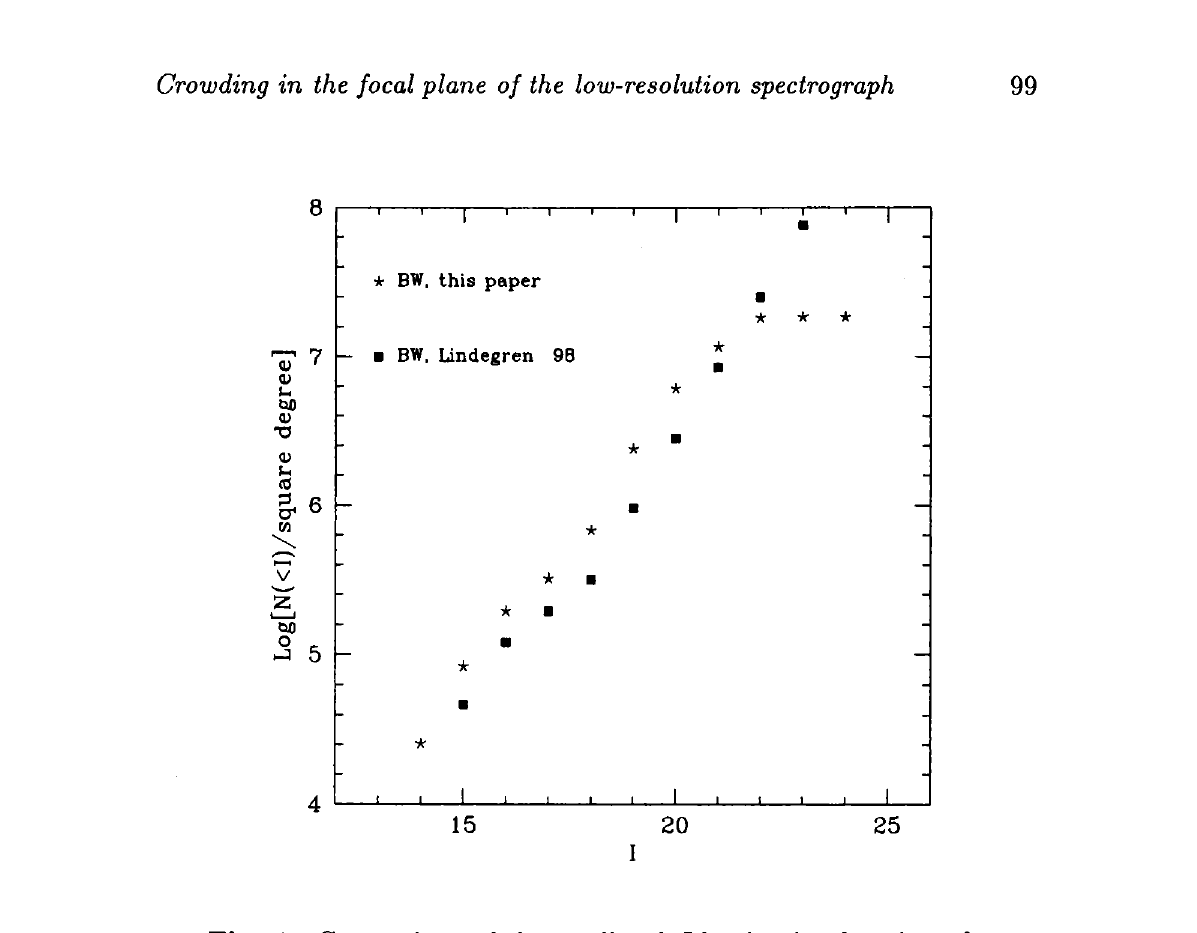
Fig. 1. Comparison of the predicted /-luminosity function of stars toward Baade's Window, £ = 1 deg, b = - 4 deg, with the luminosity function of Lindegren